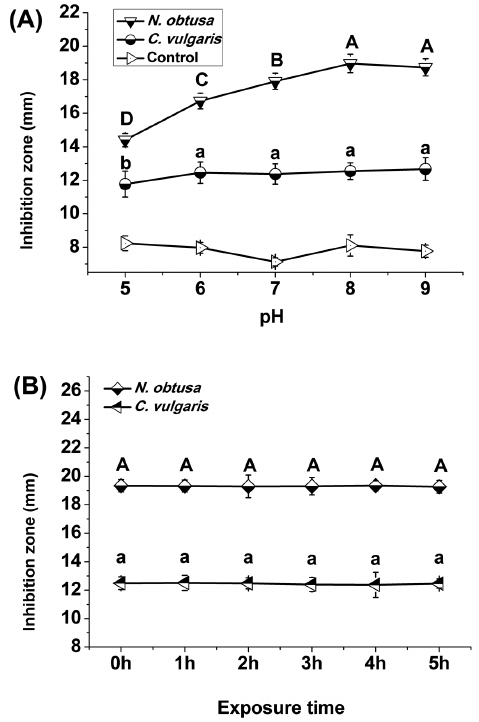
Fig. 4: Effect of pH (A) and UV (B) on antimicrobial activities in extracts from N. obtusa and C. vulgaris against S.aureus. For pH effect, the control sets were prepared using 80% ethanol that no extract was added. Different letters indicated significant differences (p<0.05; one-way analysis of variance (ANOVA) and Duncan’s multiple range test). Bars represent the means ± standard deviation. Each was rep- licated nine